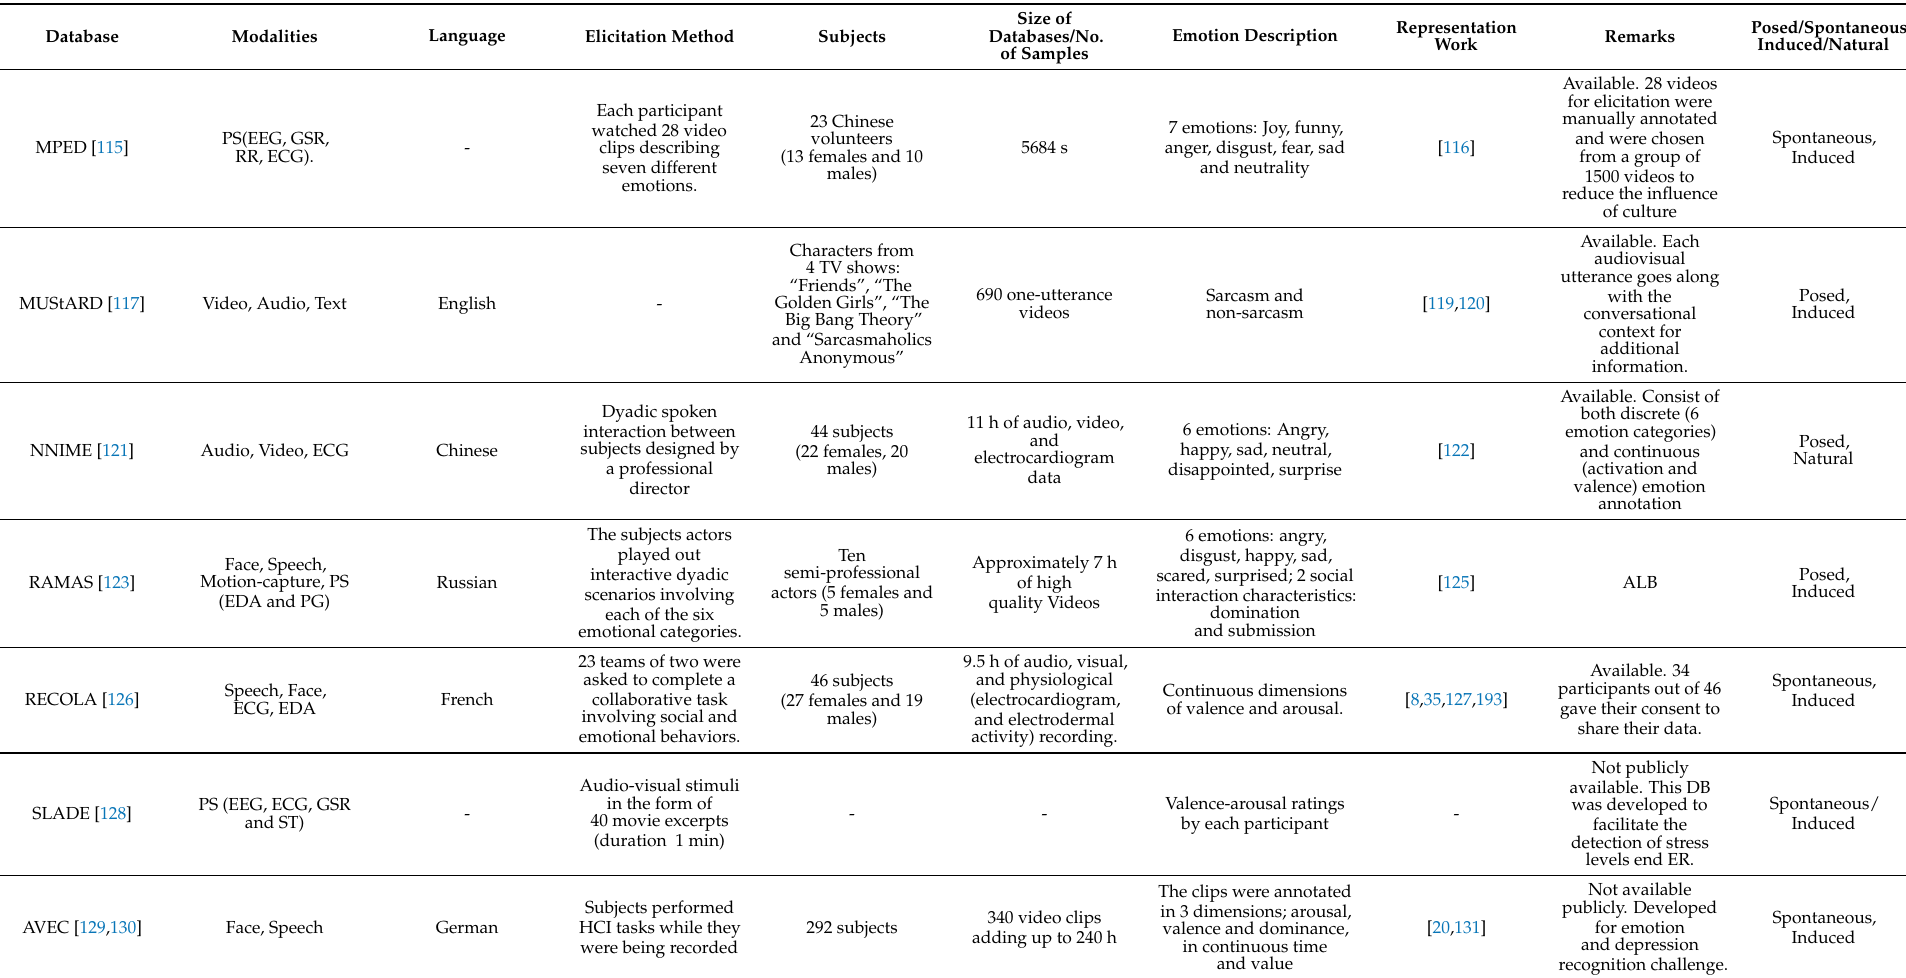
6 emotions: Angry, happy, sad,